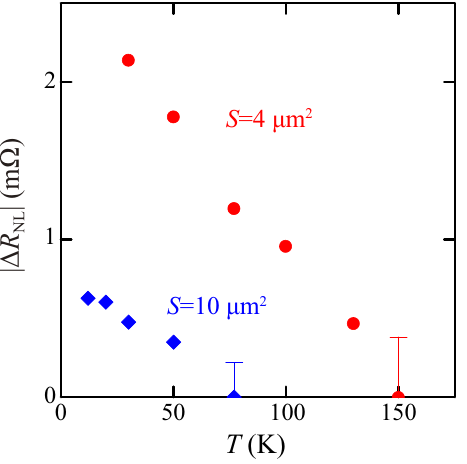
Figure 5. Temperature dependence of spin signal for LSVs with S = 4 (circle) and 10 (diamond) µ m 2